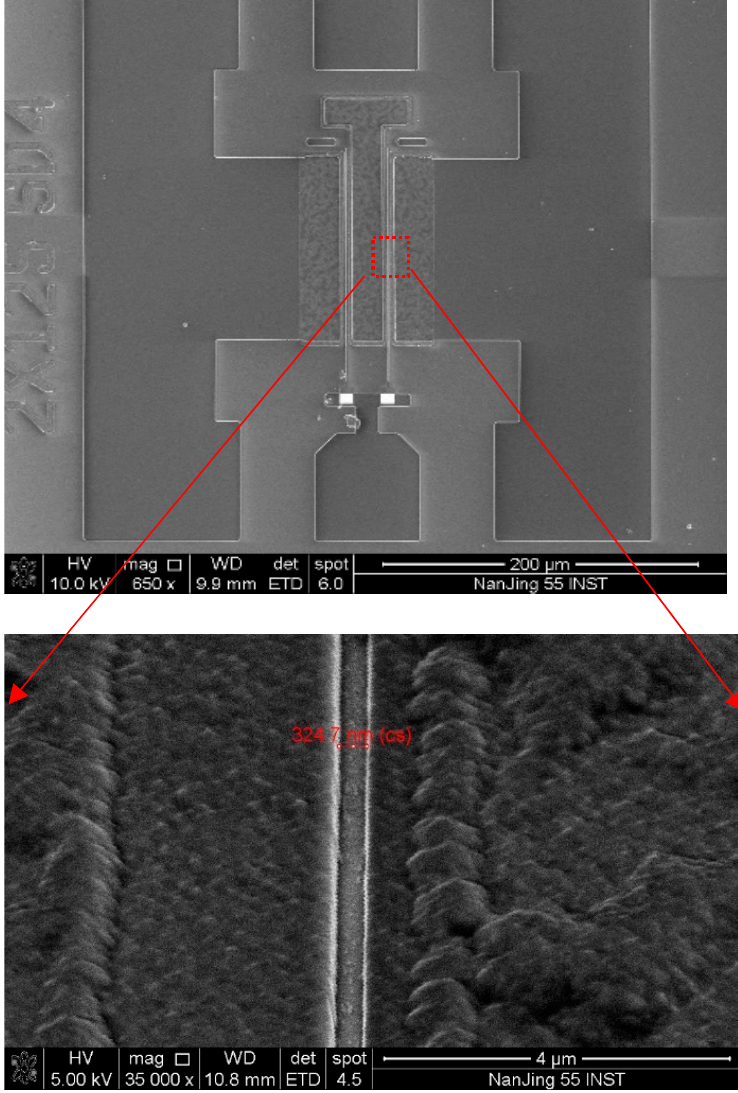
Figure 2. Etching quality of the NDC for gate region with 0.3 μ m.